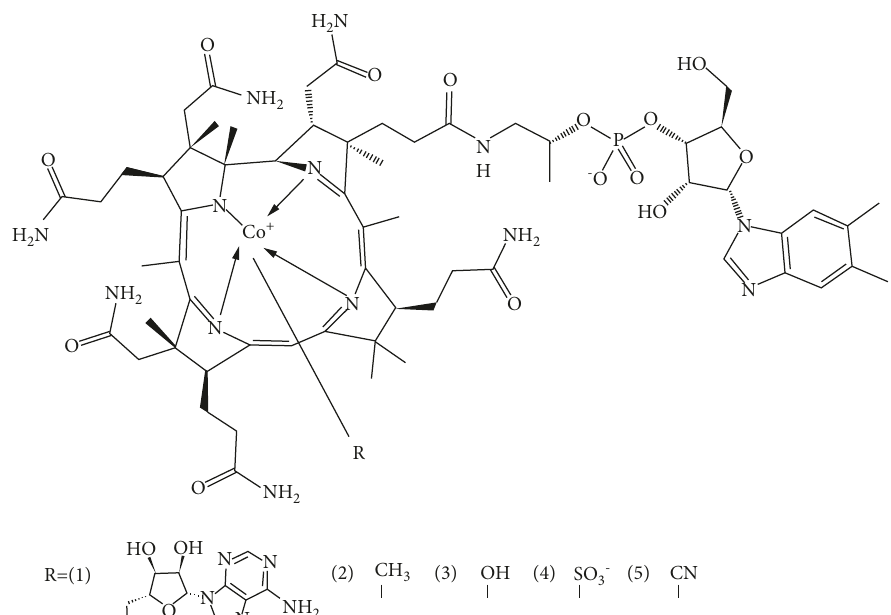
Figure 1: Structure of vitamin B 12 : (1) 5 ′ -deoxyadenosylcobalamin; (2) methylcobalamin; (3) hydroxocobalamin; (4) sulphitocobalamin; (5)